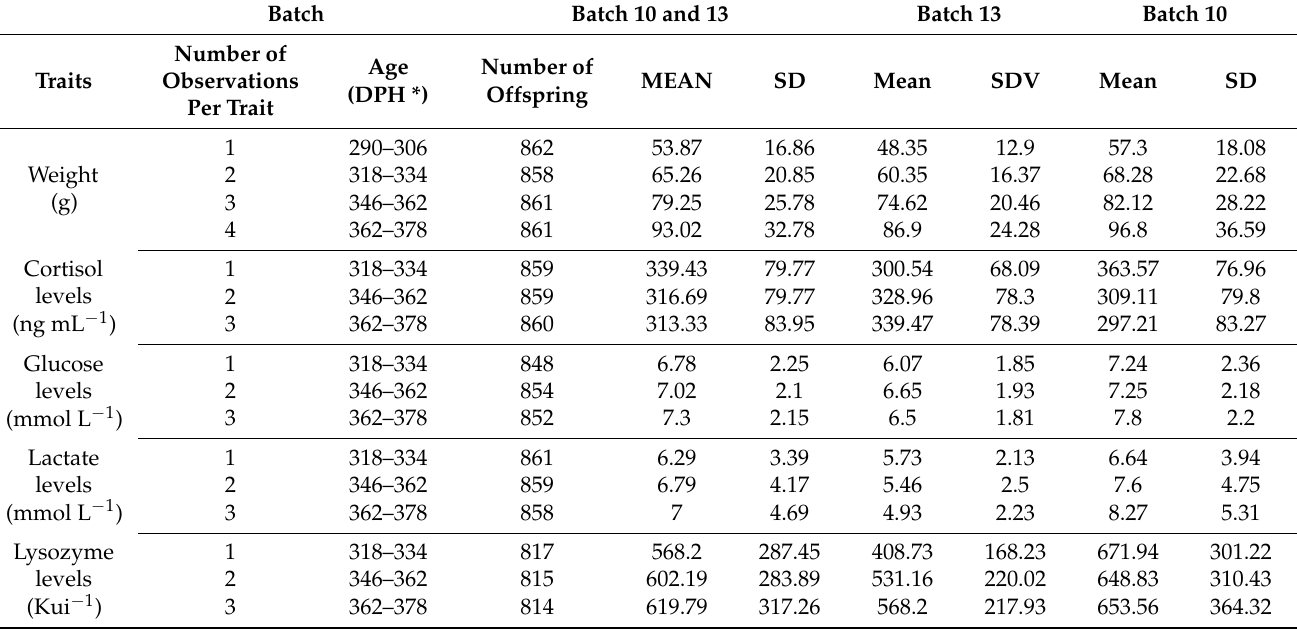
Table 1. Descriptive statistics for the traits.